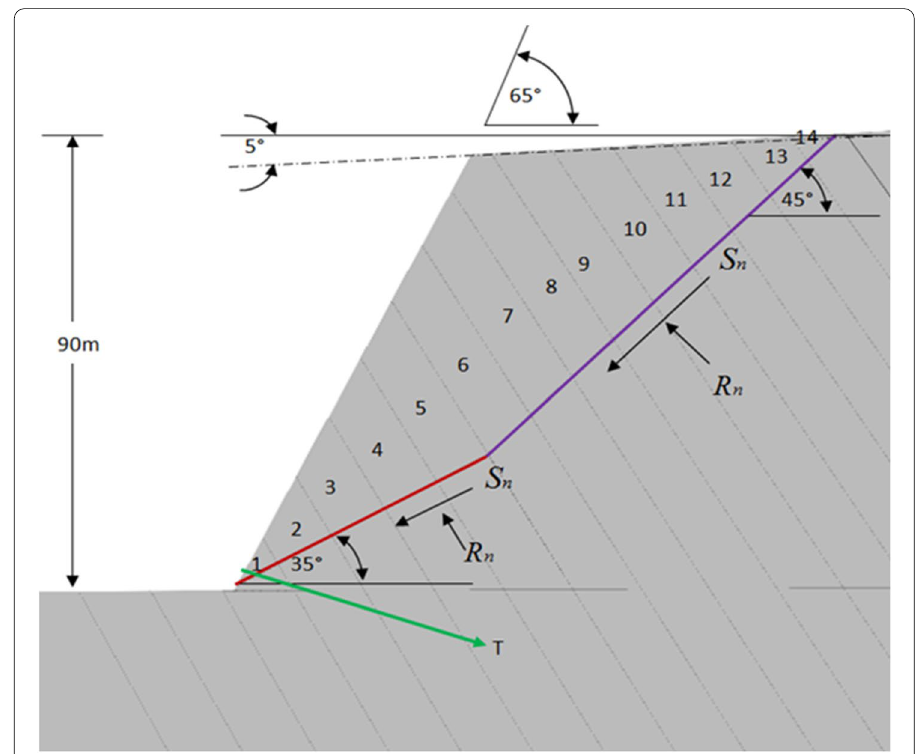
Fig. 8 Conceptual slope model and its geometry